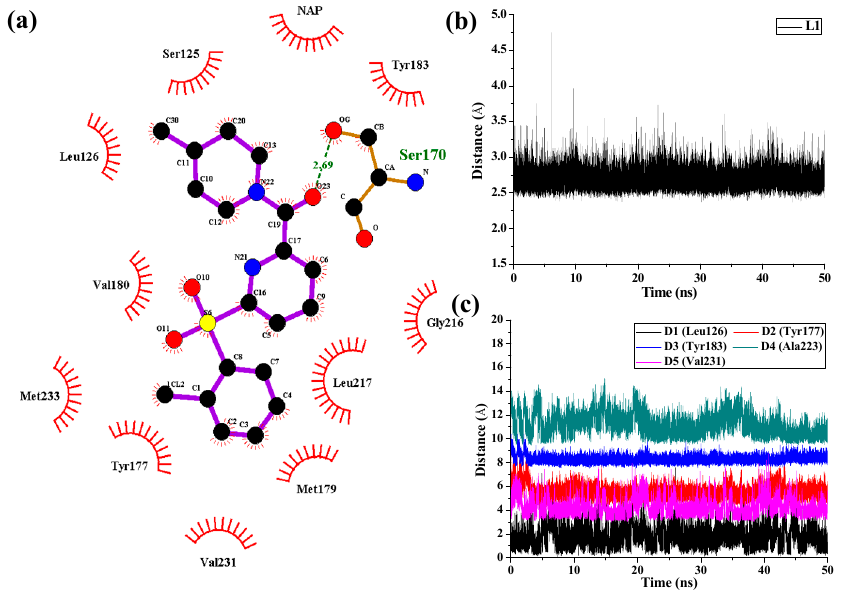
Figure 8. ( a ) H-bonds and hydrophobic interactions between 11 β -HSD1 and compound 14 generated by LIGPLOT program. ( b ) H-bond interaction of 14 in the binding site with time evolution. L1 represents the distances between the amide carbonyl oxygen and the side chain hydroxyl of Ser170. ( c ) Mass-center distances associated with hydrophobic interactions between 11 β -HSD1 and 14 in the binding site over 50 ns of MD trajectories. The curve of D1 is shifted downward by 3.0 Å. D2, D3, and D4 are shifted upward by 1.0 Å, 4.5 Å, and 6.0 Å, respectively.